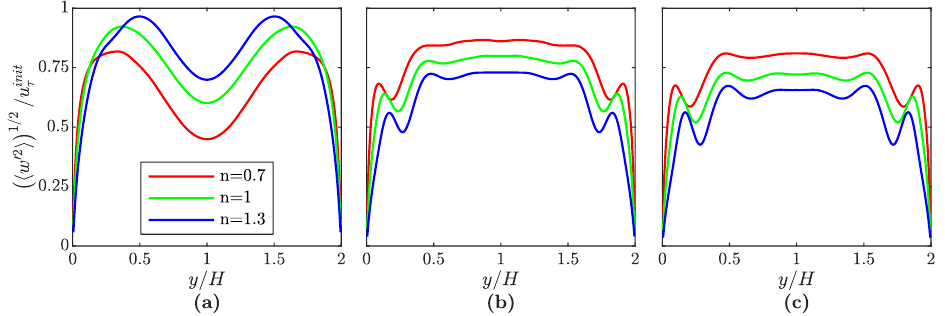
Figure 11. Root mean square of the span-wise velocity fluctuations w (cid:48) , normalized by the friction velocity of the initialization setup, as a function of the wall-normal coordinate for the single-phase ( a ) and the two-phase setups with Eo = 0.3125 ( b ) and Eo = 3.75 ( c